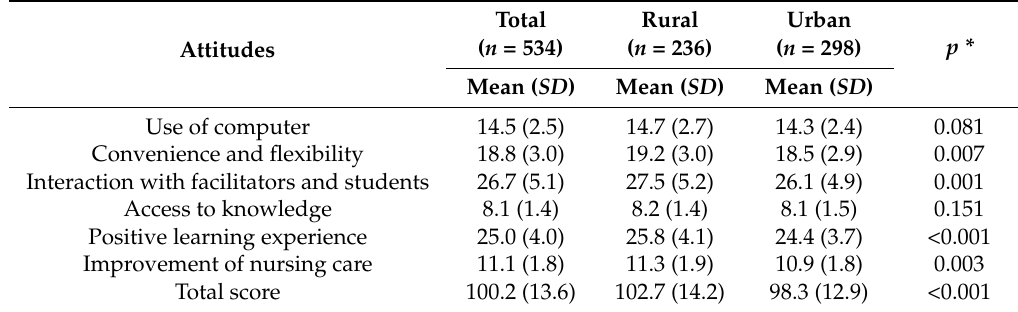
Table 2. Comparison of attitudes toward online learning between rural and urban nurses.